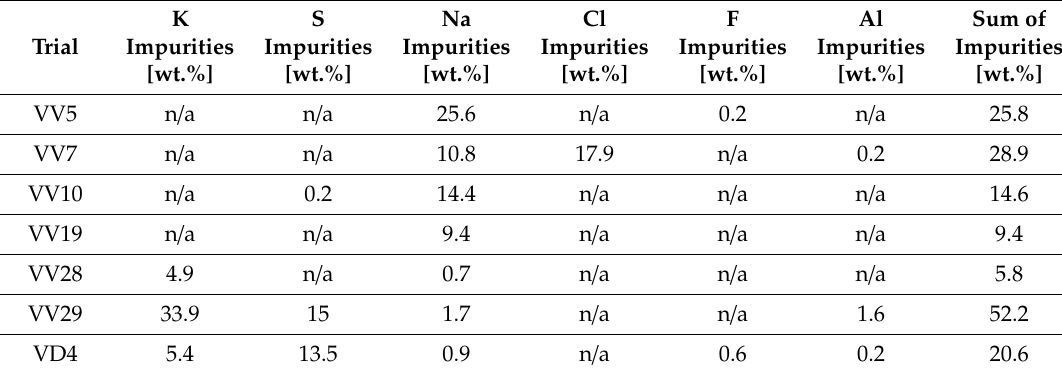
Table 8. Impurities occurring within the best-case scenarios of each solvent yields based on ICP-OES analysis.